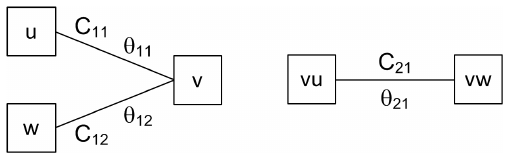
Figure 1. Composition of